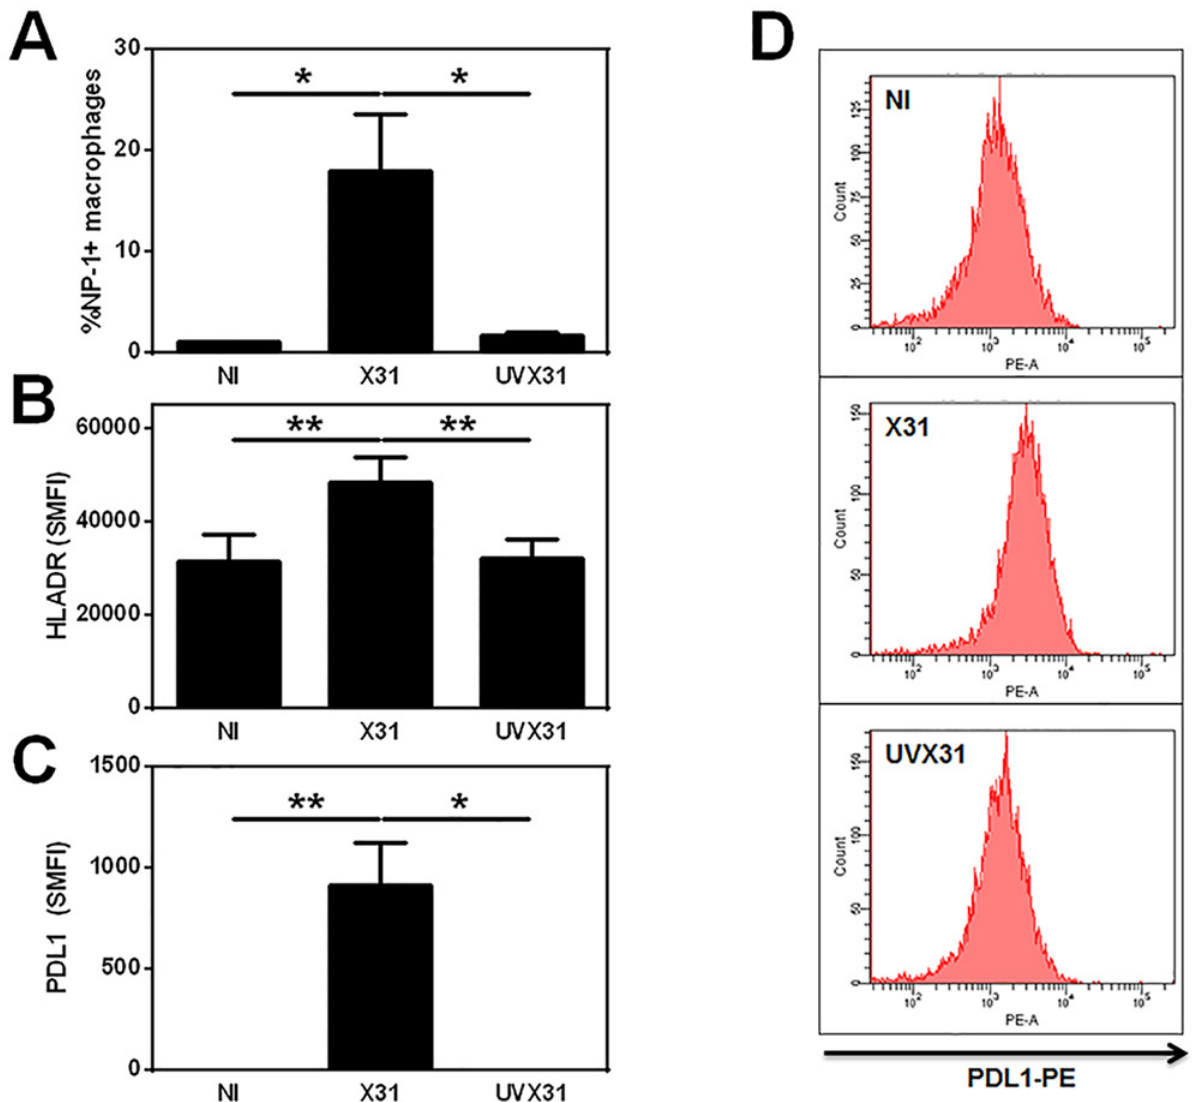
Fig 3. Infection of human lung macrophages by X31. Human lung macrophages were isolated by plate adherence prior to infection with 4000 pfu/ml of H3N2 X31 influenza virus or a UV-irradiated aliquot of virus (UVX31) for 2 h. After washing, media was replaced and the cells incubated for a further 22 h before supernatants and cells were harvested. Cells were analysed for intracellular viral NP1 expression or cell surface expression of HLA-DR and PD-L1 using flow cytometry. Histograms showing flow cytometry data of A) Viral NP1 expression (% cells), B) HLA-DR expression (specific mean fluorescence intensity — SMFI) and C) PDL1 expression (SMFI) from isolated human lung macrophages are expressed as means ± SE of 4 independent experiments. D) Representative histograms demonstrating increase in PDL1 expression in response to influenza infection are shown. Data analysed using a paired t-test * p < 0.05, ** p <